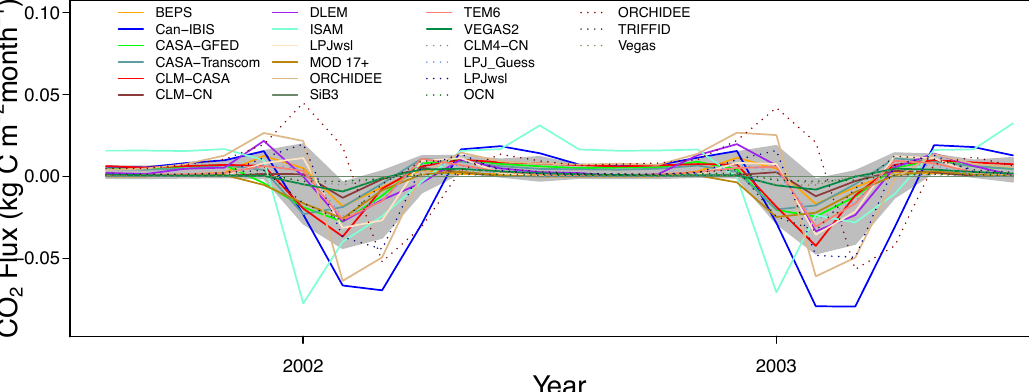
flux for the Alaskan Arctic (North Slope), showing two years, 958 2